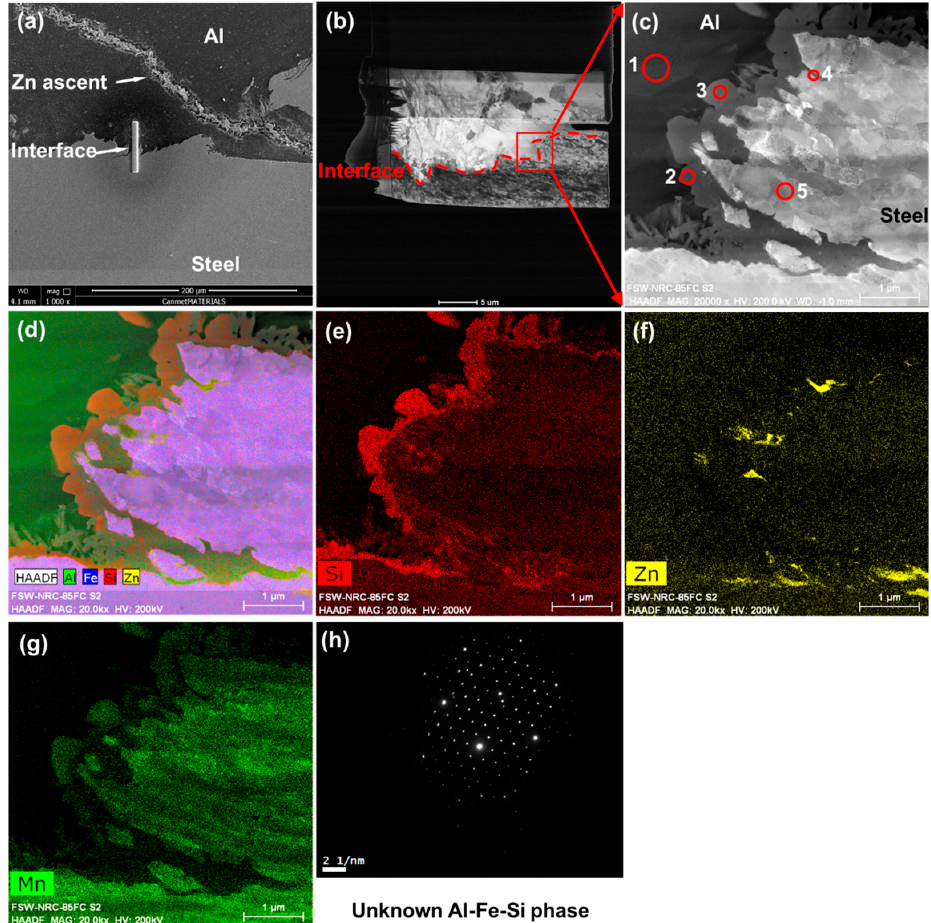
Figure 15. Interfacial microstructure at the hook zone of sample B: ( a ) FIB sampling position, ( b ) TEM overview of the interfacial zone, ( c ) HAADF image, ( d ) EDS combination elemental map, individual elemental maps of ( e ) Si, ( f ) Zn, and ( g ) Mn, and ( h ) SAD pattern. Table 3. EDS spot analyses of the interfacial zone (see Figure 15c). Element (at. Position